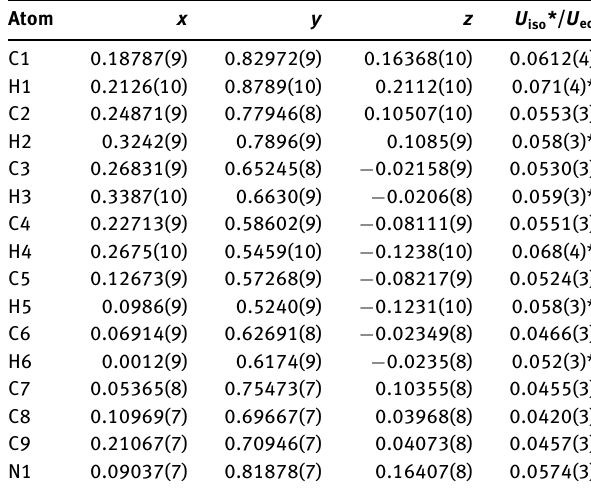
Table 2: Fractional atomic coordinates and isotropic or equivalent isotropic displacement parameters (Å 2